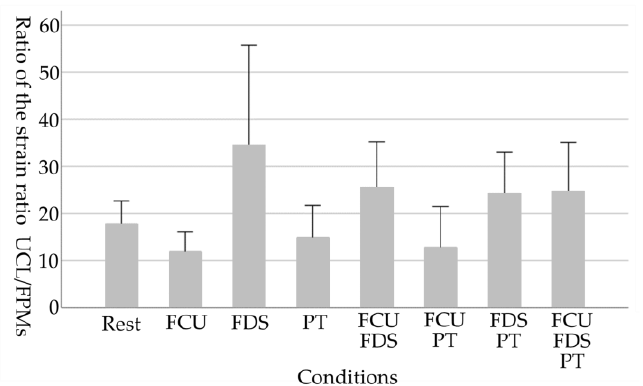
Figure 5. Changes in FPMs due to selective contraction of the FPMs. A higher value in strain ratio indicates harder (stiffer) tissue. Asterisks indicate significant differences compared to the resting condition ( p < 0.05). Error bars in the graph are standard errors. FPMs, forearm flexor – pronator muscles; FCU, flexor carpi ulnaris; FDS, flexor digitorum superficialis; PT, pronator teres.